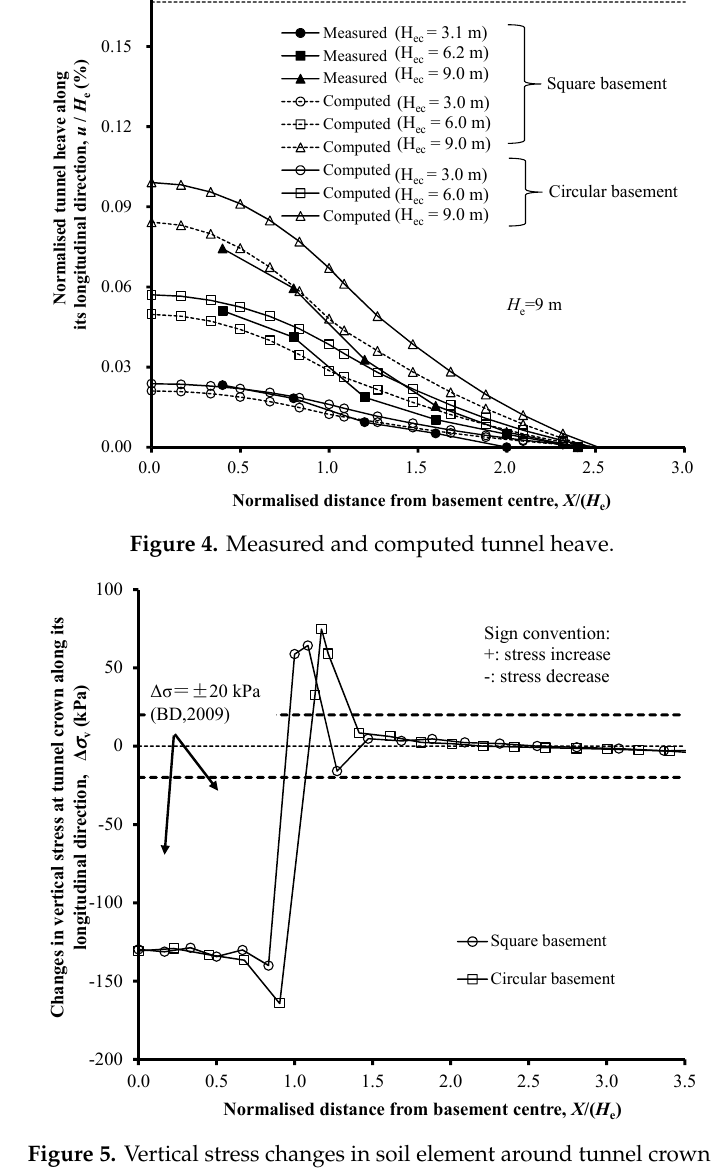
Figure 5. Vertical stress changes in soil element around tunnel crown.